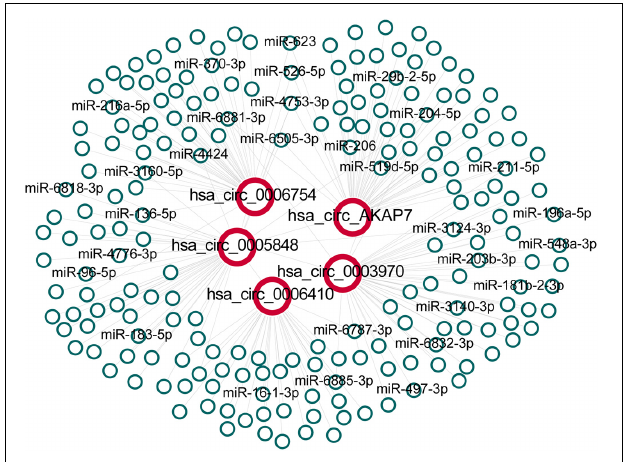
FIGURE 3 | The network between five specific circRNAs and their predicted interactions of miRNAs. All interactions between circRNAs and miRNAs were obtained and extracted for hsa_circ_0006410, hsa_circ_0003970, hsa_circ_0006754, hsa_circ_0005848 and hsa_circ_AKAP7 to build the